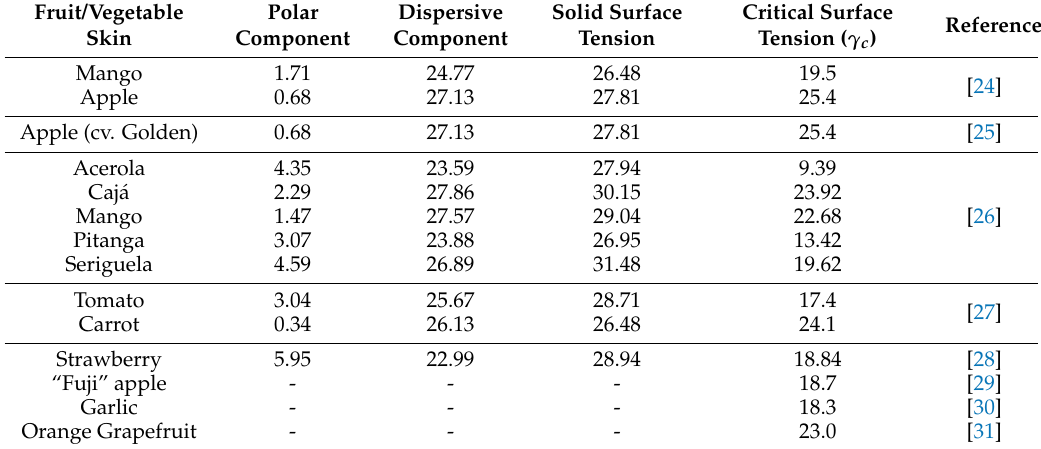
Table 1. Surface properties of fruit and vegetable skins/peels (mN · m − 1